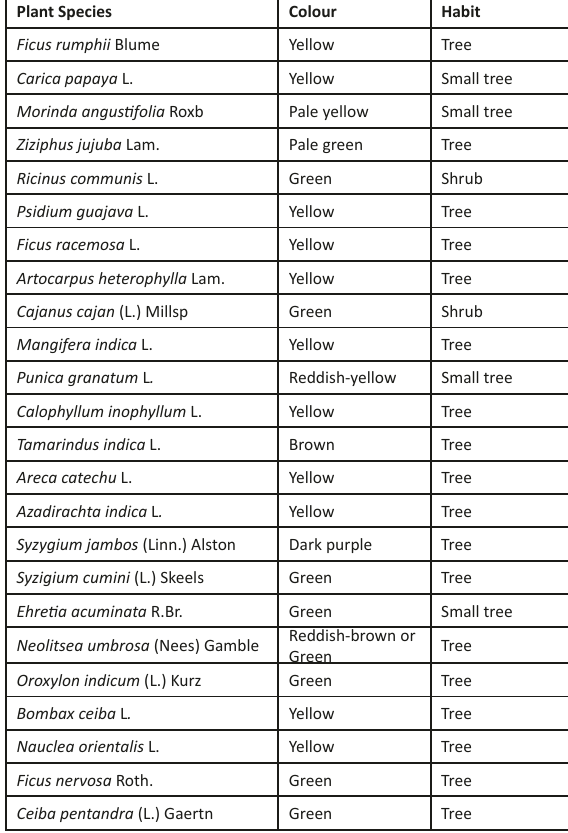
Table 3. Colour of fruits eaten by P.